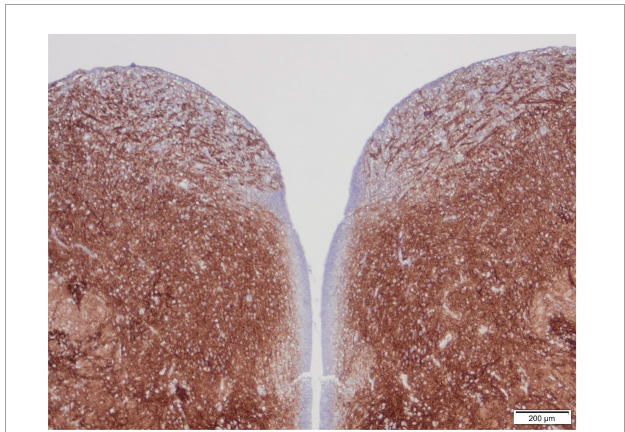
FIGURE4 Transverse section of the normal tegmentum of the medulla oblongata at the level of the caudal end of the 4th ventricle, of a 15-week human fetus, showing synaptophysin immunoreactivity. The dorsal regions with coarse axons and small neurons just beneath the ventricle on either side are the area postrema. The tegmentum otherwise showed intense reactivity in all gray matter regions but not in longitudinal white matter tracts such as the tractus solitarius at the lateral edge of the section, with strong reactivity surrounding this fascicle as the nucleus of the tractus solitarius. Reproduced from reference (Sarnat et al., 2019).